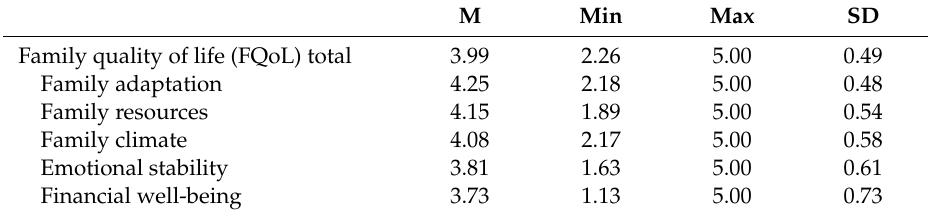
Table 5. Descriptive statistics of the total and each family quality of life dimension for the CdVF-ER < 18. M